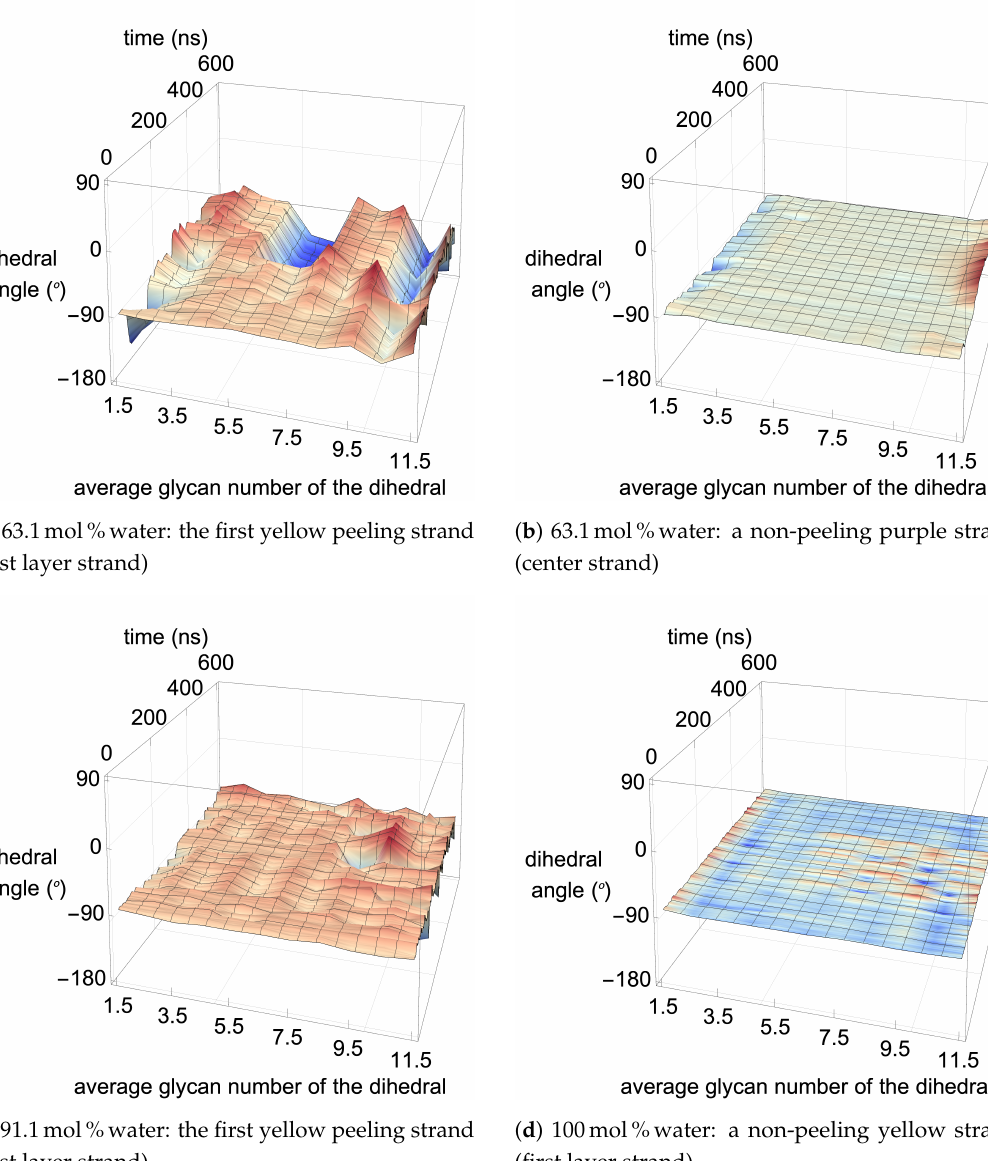
Figure 17. The cellulose strand twisting for various concentrations at 360K. The cellulose strand twisting is shown between the following: ( a ) the first yellow peeling strand (first layer strand) at 63.1mol%water; ( b ) a non-peeling purple strand (center strand) at 63.1mol%water; ( c ) the first yellow peeling strand (first layer strand) at 91.1mol%water; and ( d ) a non-peeling yellow strand (first layer strand) at 100mol%water. The dihedral angle is measured, in order, from the O5-C1-O4-C4 atoms, which are between two glycans (see Figure 2). Since the dihedral angle is between two glycans in the cellulose strand, the average glycan number is used in the plots (i.e., the dihedral angle between glycans 1 and 2 is represented as 1.5). Please see Figure 4 for the cellulose strand colors. The data were averaged over 1000 data points, using a rolling average. Every 100th point was then plotted to maintain plot clarity